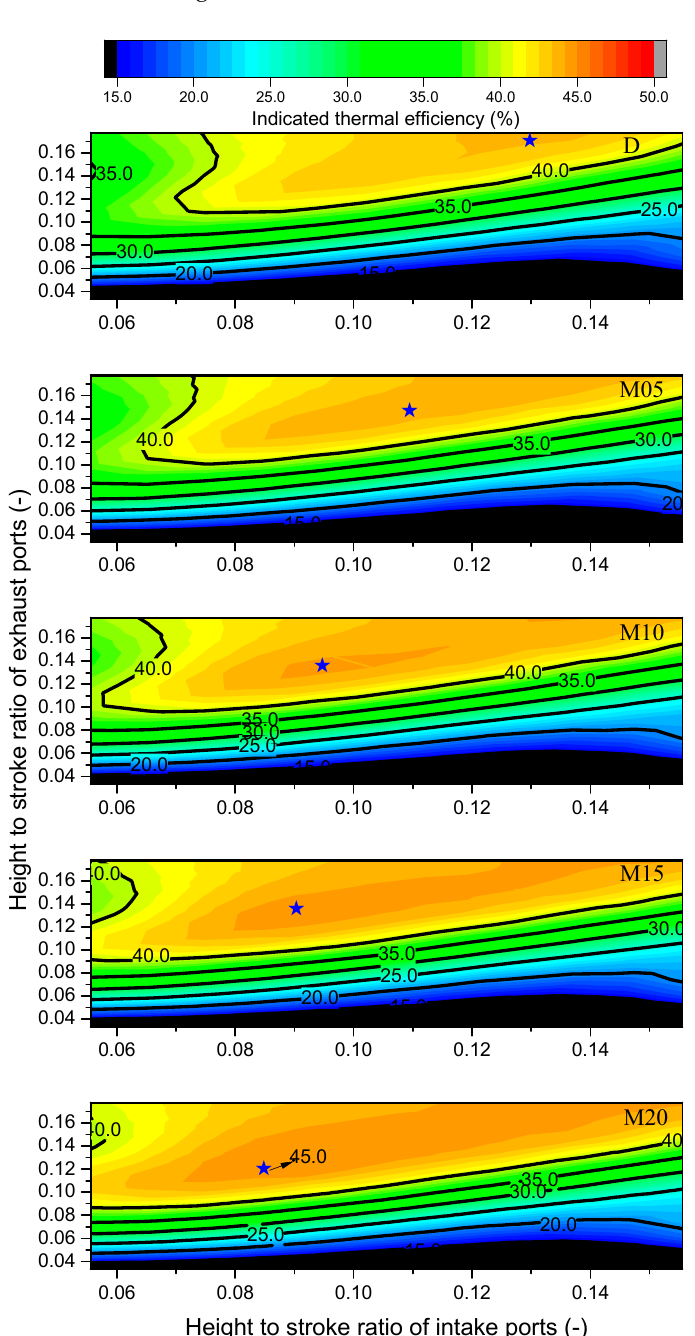
Figure 12. Indicated thermal efficiency under the interaction of the intake and exhaust